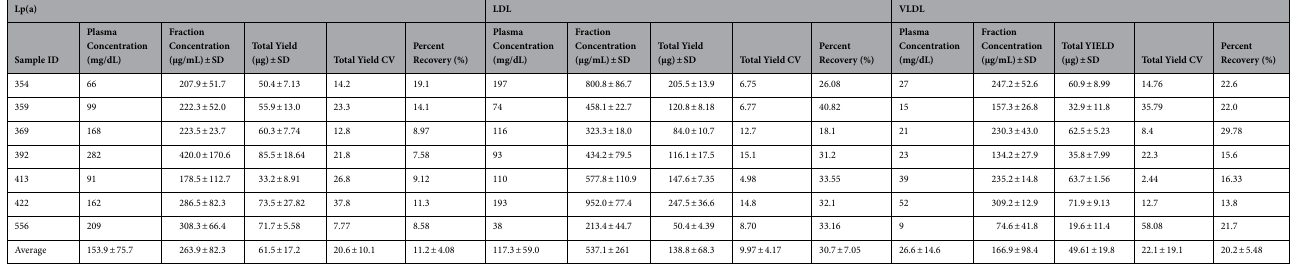
Table 2. Small-volume lipoprotein isolation yields. Lipoprotein yields and concentrations are determined by Pierce BCA assay and are displayed as average ± SD from 2 to 4 individual isolations for each